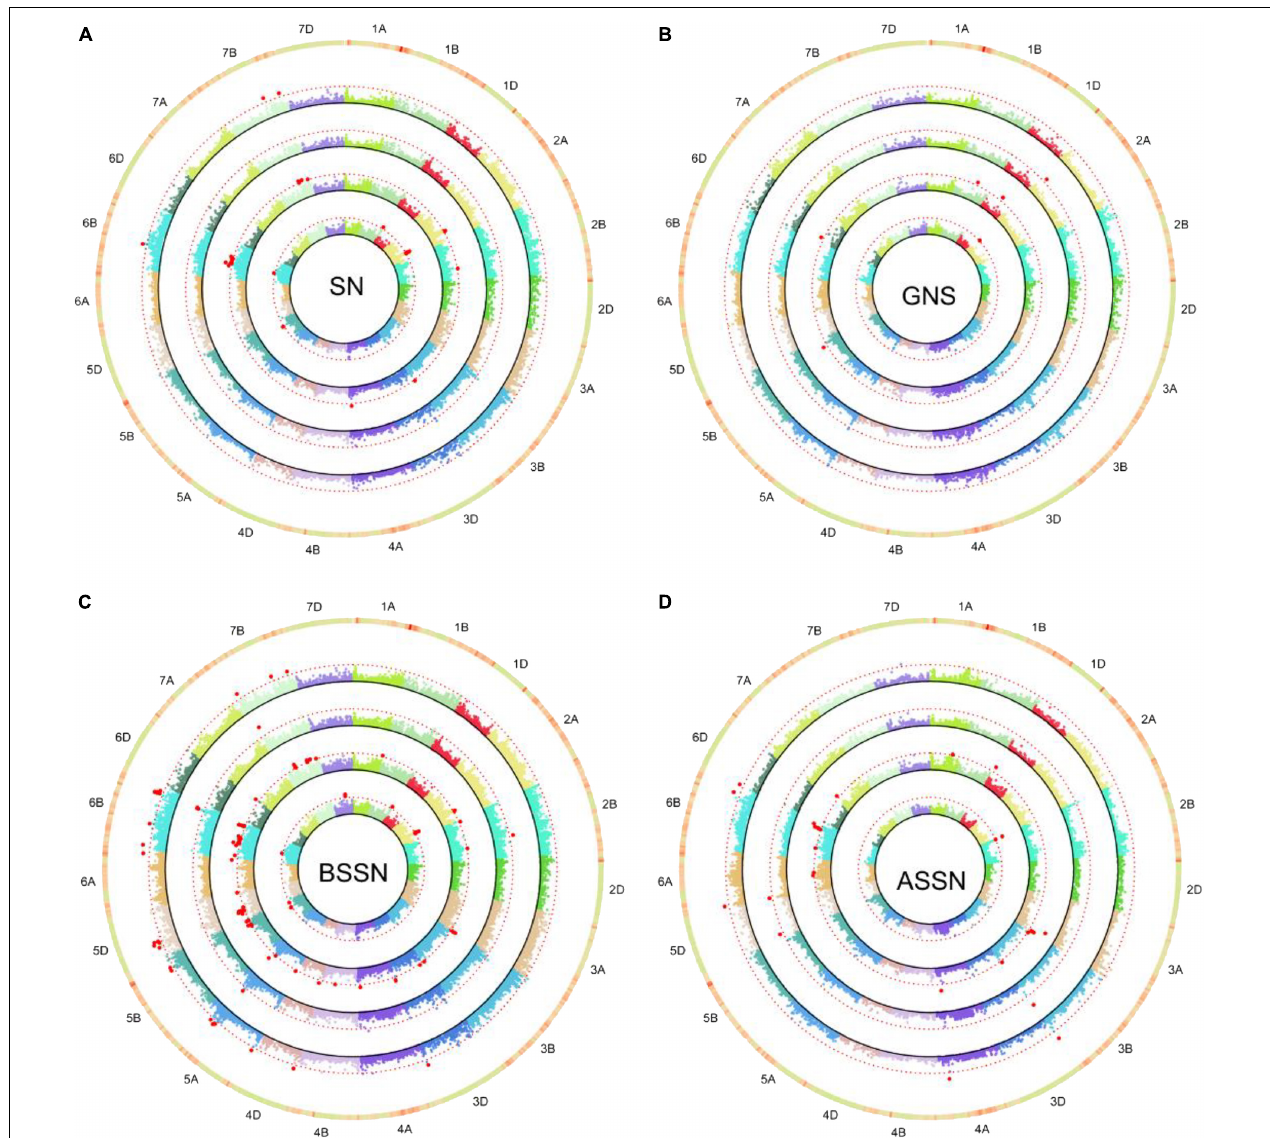
FIGURE 3 | Circular-Manhattan plots for SNP significantly associated with SN (A) , grain number per spike (GNS, B ), the basal sterile spikelet number (BSSN, C ), and the top sterile spikelet number (ASSN, D ) under two water regimes identified by genome-wide association study based on the mixed linear model (MLM). Circles from inner to outer represents I1-BLUP, I3-BLUP, BLUP-ALL, and DTC trait , respectively. The dashed red line represents the threshold –log 10 ( P -value) value of 3.0. SNPs markers that met this significant level are highlighted with red